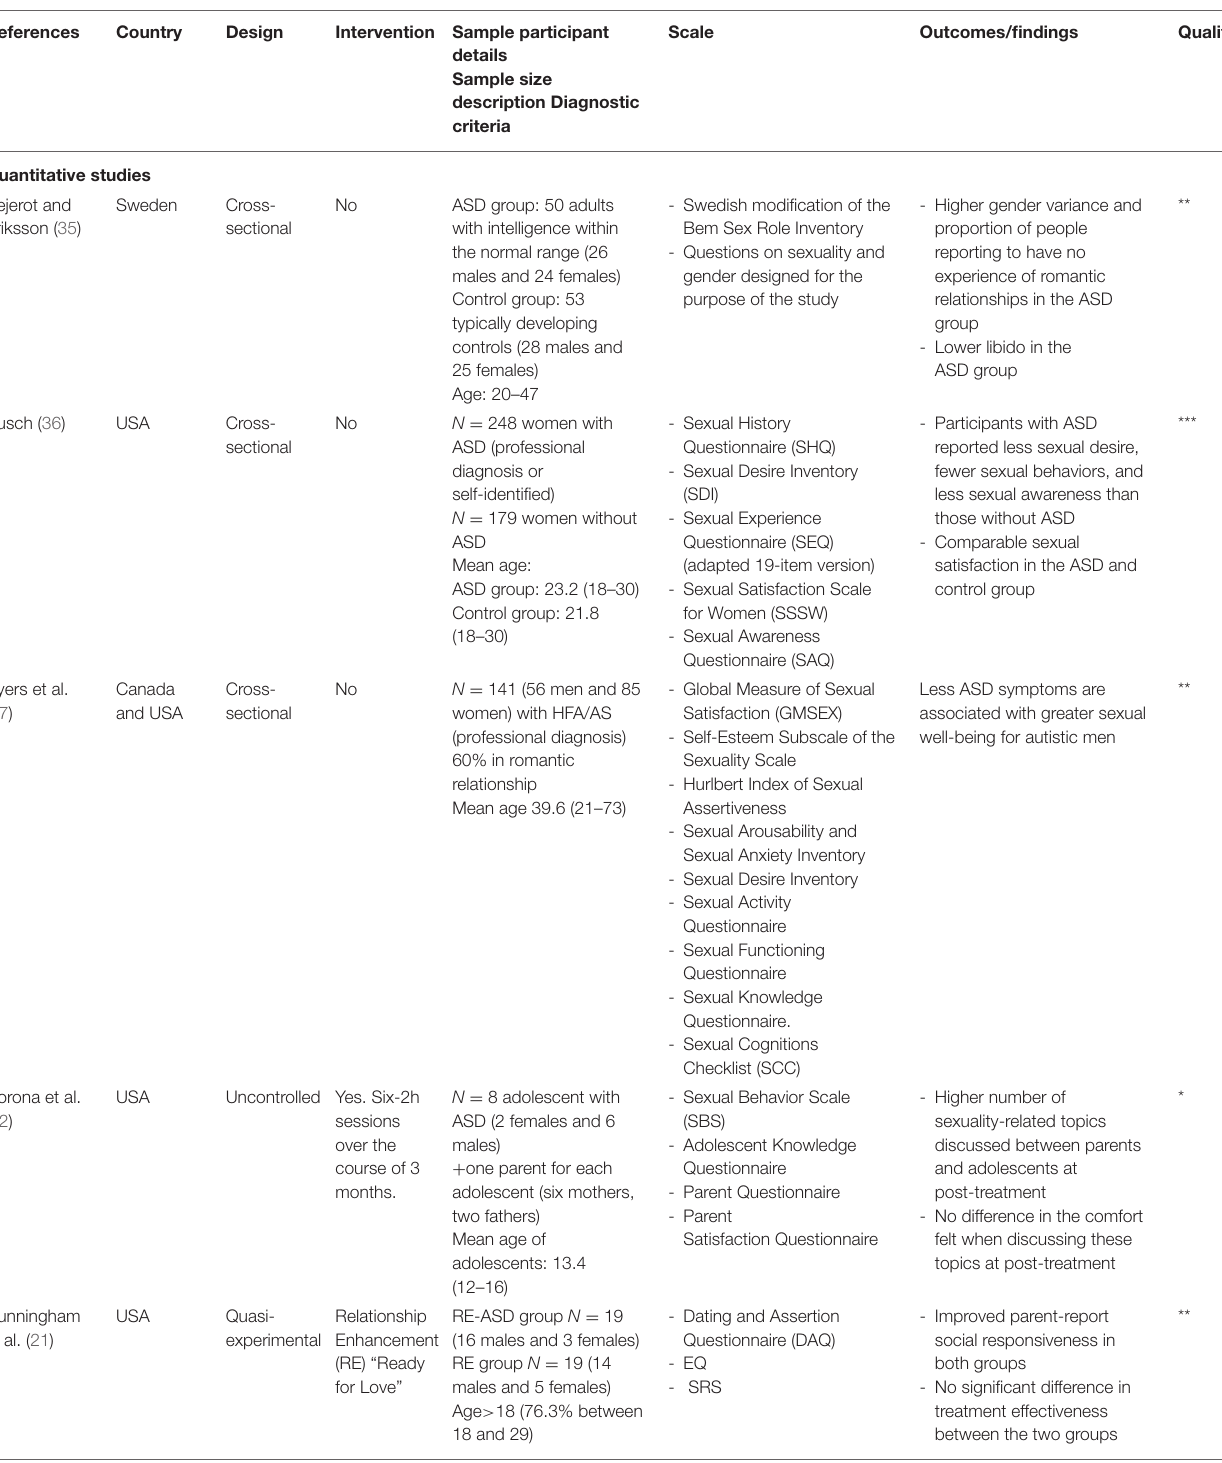
TABLE 2 | Included studies reporting on romantic relationships/sexuality in autistic